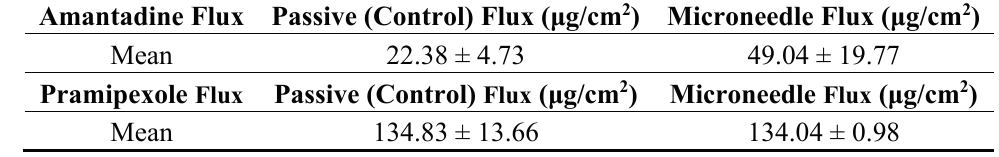
Table 3. Transdermal flux ( μ g/cm 2 /h ± SD) of amantadine and pramipexole following treatment with a 500 μ m long microneedle roller. Passive flux values served as controls ( n =